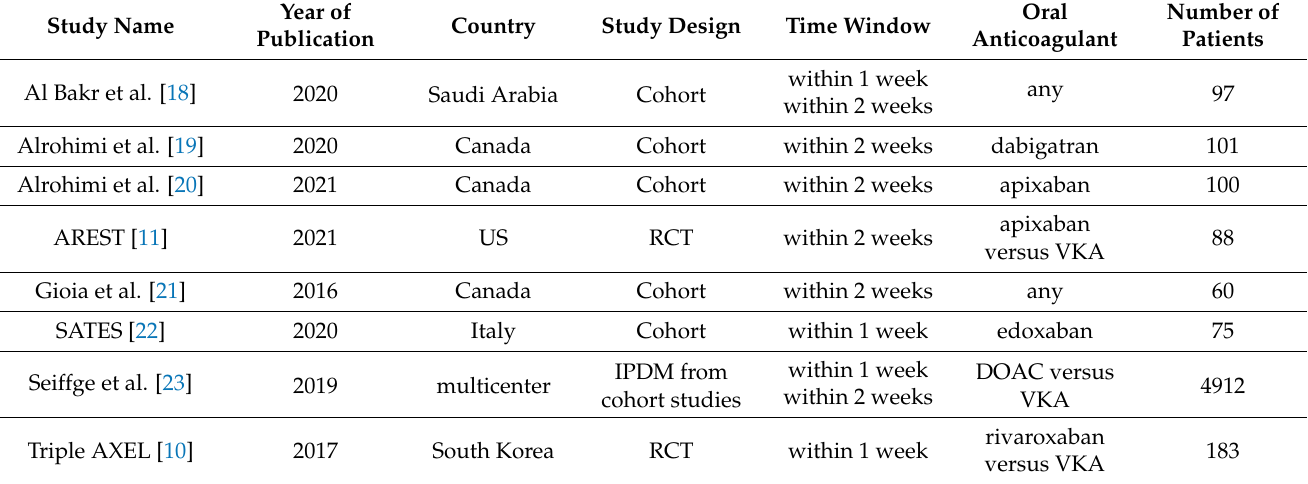
Table 1. Characteristics of the included